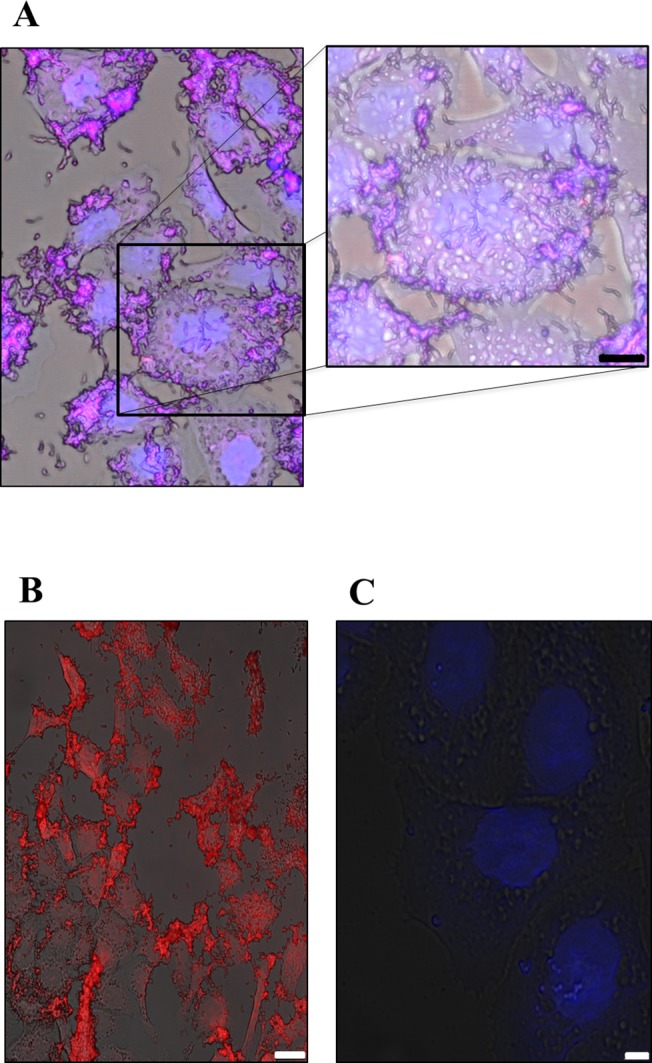
Confocal microscopy images of AGS cells infected with H. pylori 26695 strain.A. Detection of H. pylori by the Cy3_ HP_ LNA/2OMe _PS _oligonucleotide probe in infected epithelial cells. Channel red, DAPI and bright field were overlapping. Scale bar = 10μm B. Detection of H. pylori by Cy3_ HP_ LNA/2OMe _PS _oligonucleotide probe in co-infected cells and isolates bacteria. Channel red, and bright field were overlapping. Scale bar = 25μm C. Uninfected AGS cells stained with Cy3_ HP_ LNA/2OMe _PS _oligonucleotide probe and DAPI. Channel red, and bright field and DAPI were overlapping. Scale bar = 5μm. Red: Cy3 fluorescence. Blue: DAPI staining to counterstain nuclei.